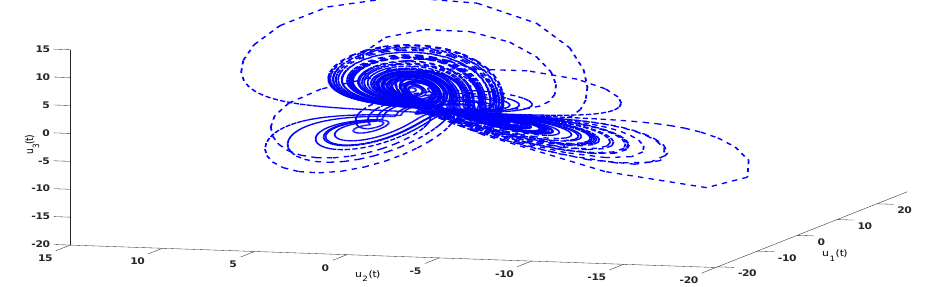
Figure 8. Three-dimensional phase diagram of the states u 1 ( t ) , u 2 ( t ) , u 3 ( t ) of the drive system (13) with fractional order q = 0.9.